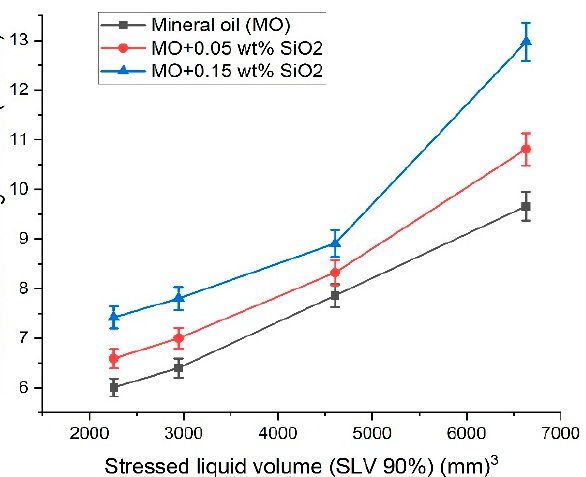
Figure 11. Graph showing the variation of maximum breakdown strength of mineral oil and its nanofluids with SLV (90%).